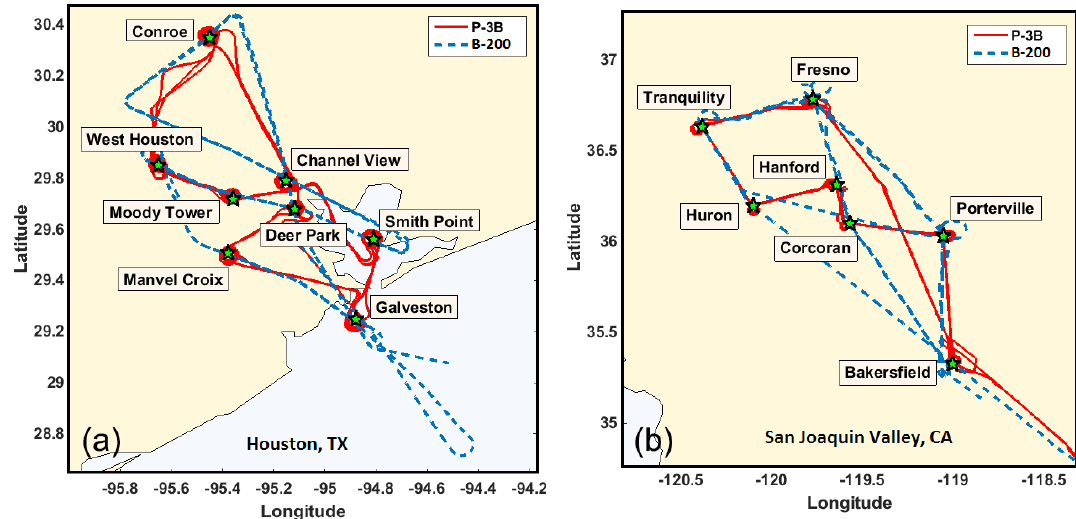
Figure 1. Map of the flight tracks for DISCOVER-AQ field campaign (DAQ) California (b) and DAQ Texas (a) . The green stars mark the location of the ground stations over which the P3B (red solid line) spiraled. The HSRL-2 instrument onboard the King Air (blue dashed line) flew over the same ground